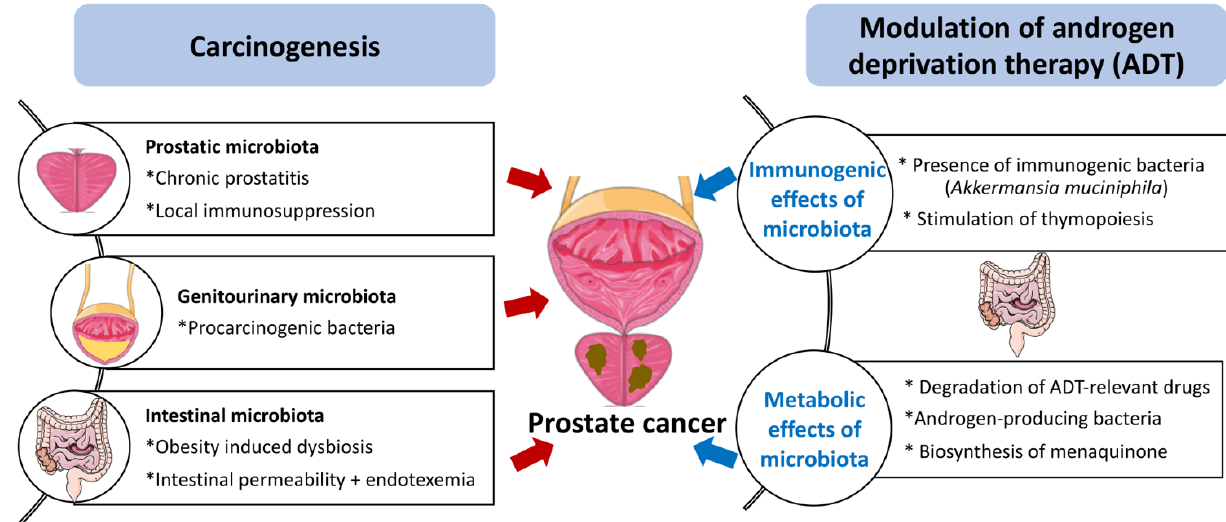
FIGURE 1: Potential mechanisms of action of the microbiota on prostate cancer carcinogenesis and sensitivity to androgen depletion ther- apy . For details consult